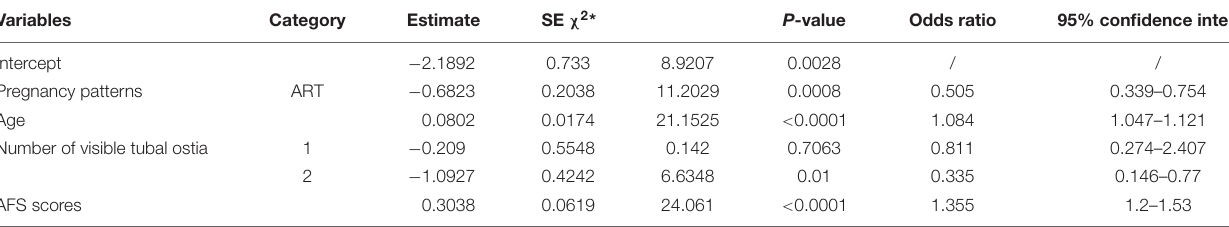
TABLE 4 | Stepwise logistic regression of the significant variables in the live birth and non–live birth groups.